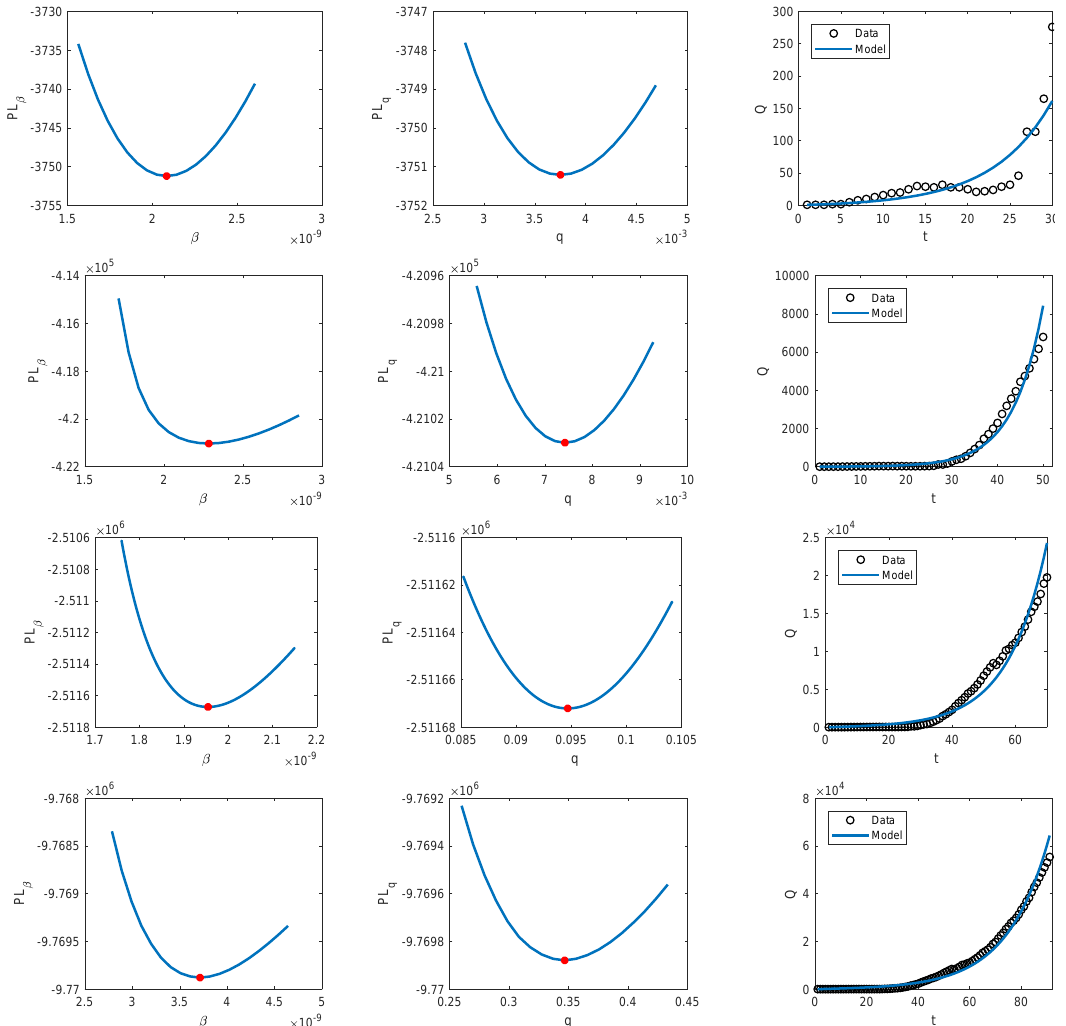
Figure 3. Parameters estimation and profile likelihood is shown in the first two columns for β and q respectively for different time intervals. The last column shows corresponding model fitting with the reported data.